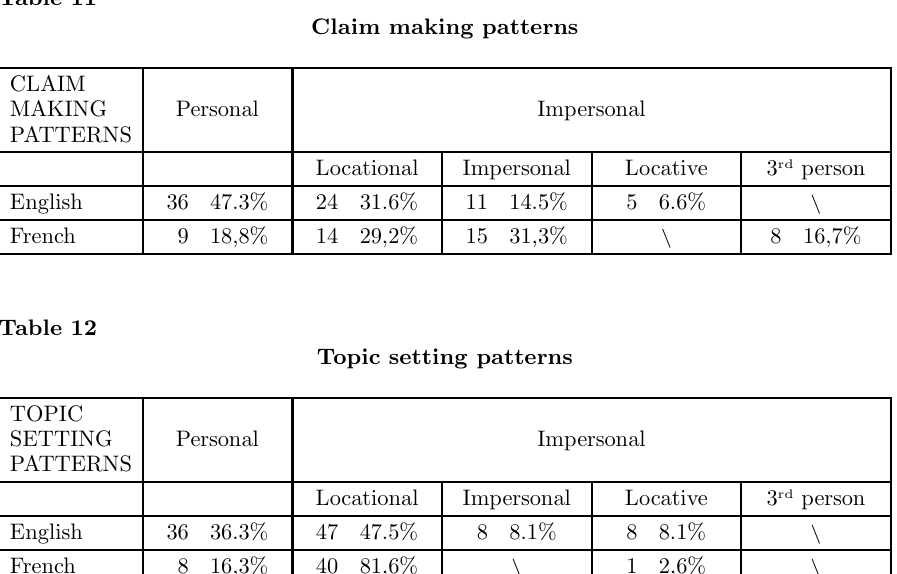
Claim making patterns Locational Impersonal Locative